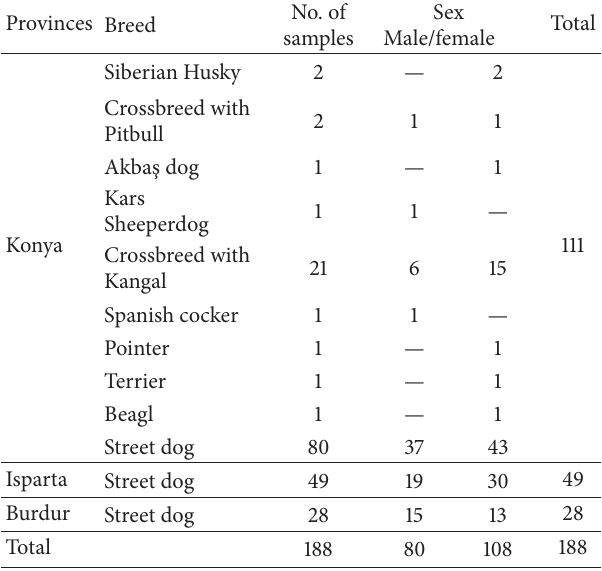
Table 1: The animals according to province, breed, and sex. Provinces Breed